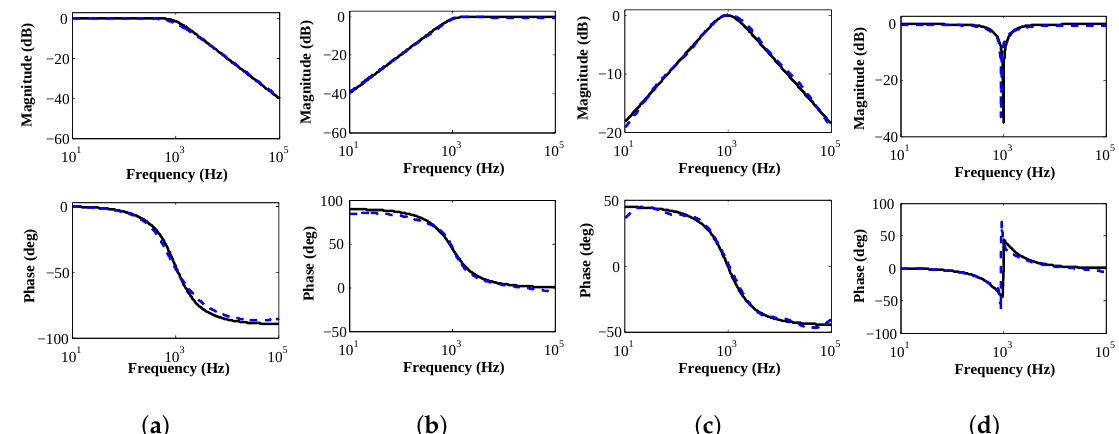
Figure 10. Comparisons between the theoretical (solid black) and experimentally (dashed blue) obtained ( a ) LP, ( b ) HP, ( c ) BP, and ( d ) BS filter frequency responses of the PLFs ( α = 0.5 ) .